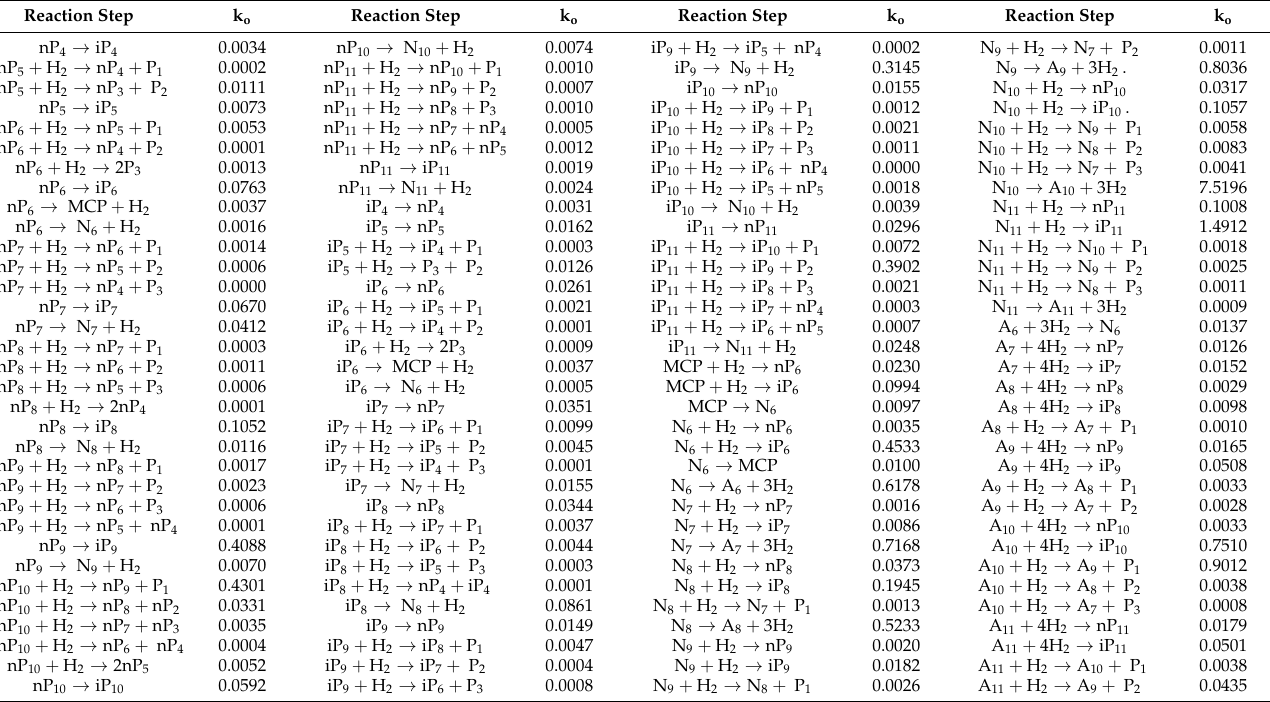
Table 2. Pre-Exponential factors of predicted kinetic model.